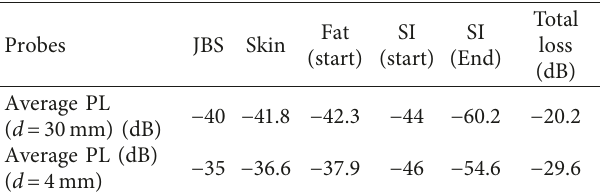
Table 11: Path loss values in dB at 4GHz using probes inside the voxel model for different